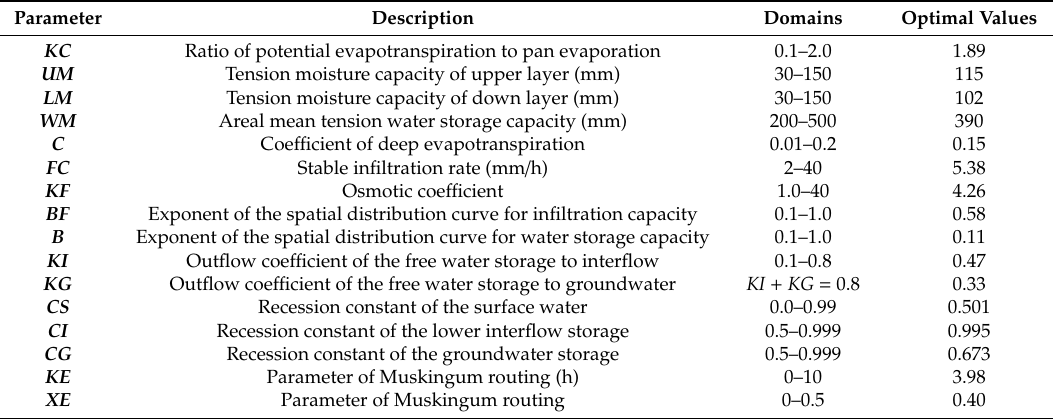
Table A3. Parameters of the proposed model along with their descriptions and ranges for Chutoulang